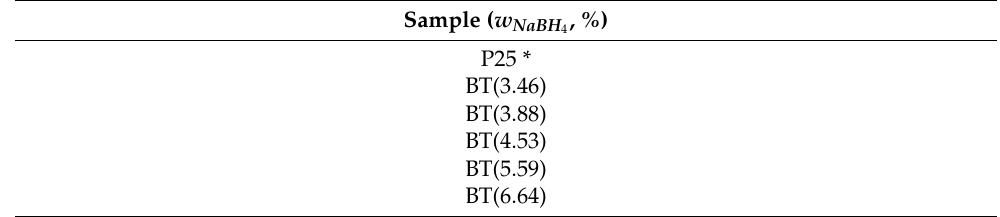
Table 1. Prepared samples of blue titania